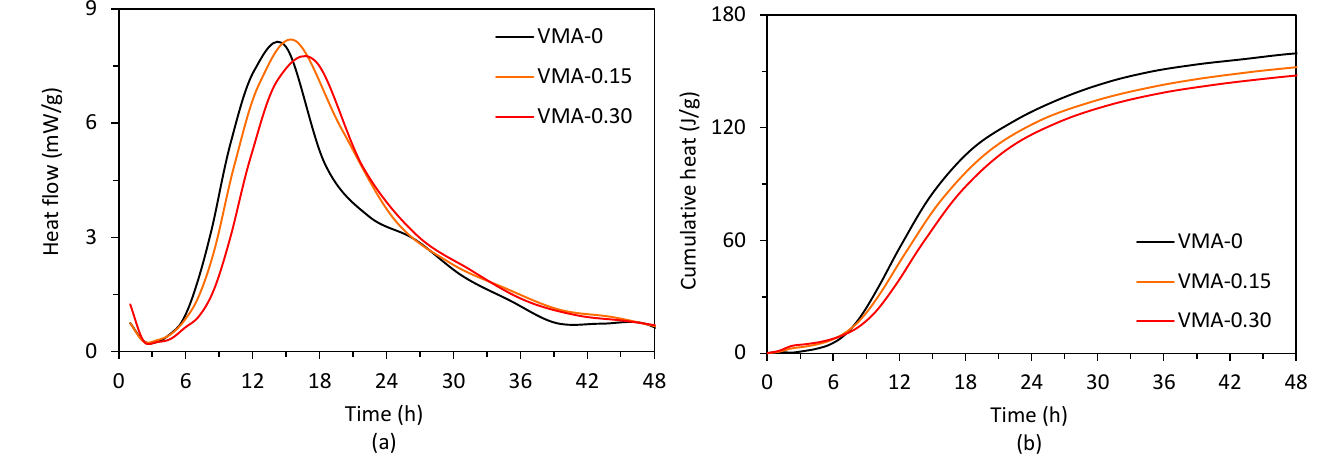
Figure 9. Heat flow ( a ) and cumulative heat ( b ) curves of cement mortars.